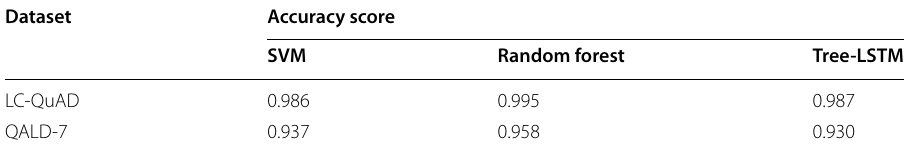
Table 2 Question type classification performance on LC-QuAD and QALD-7 datasets for various models